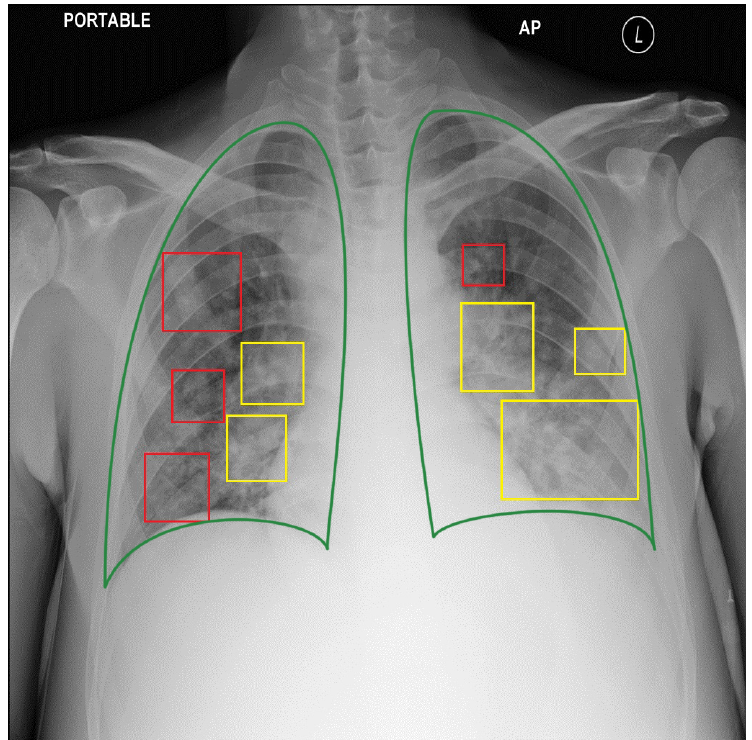
Figure 3. Visual appearance of GGO (red rectangle) and consolidation (yellow rectangle) within the lung field (green